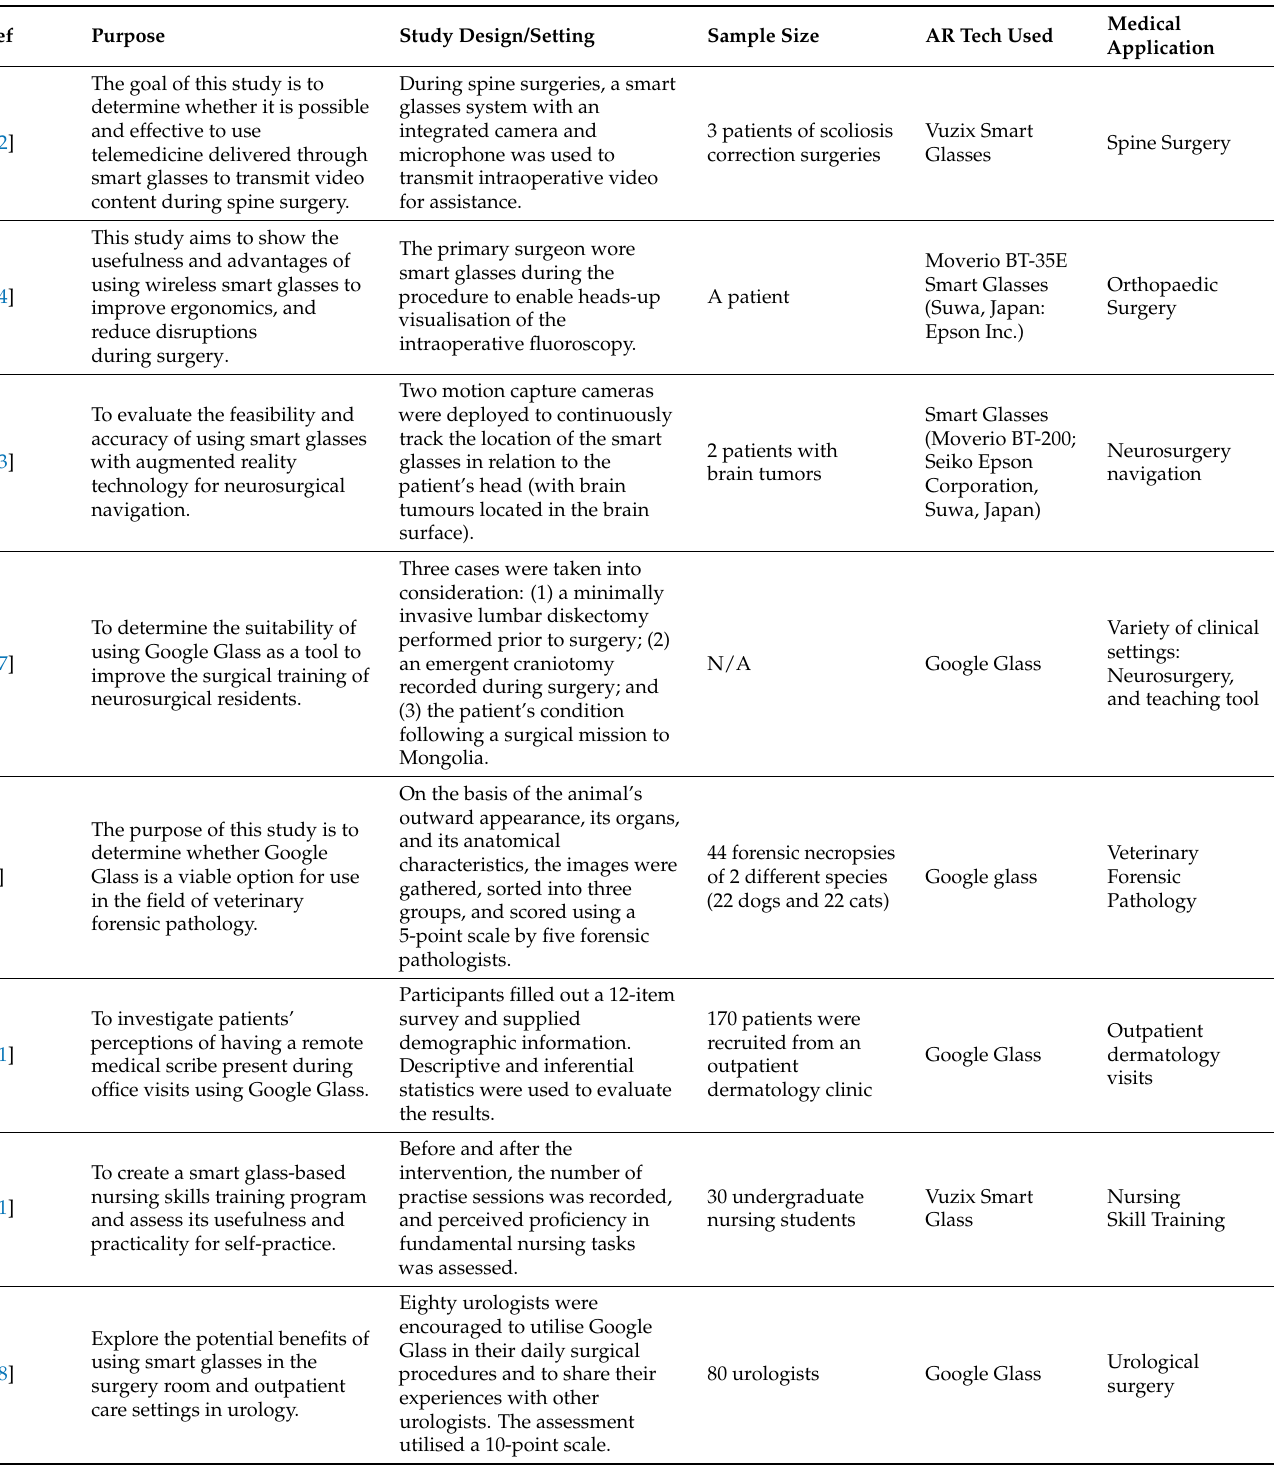
Table 1. The summary of the selected studies that focus on Google Glass applications in the healthcare